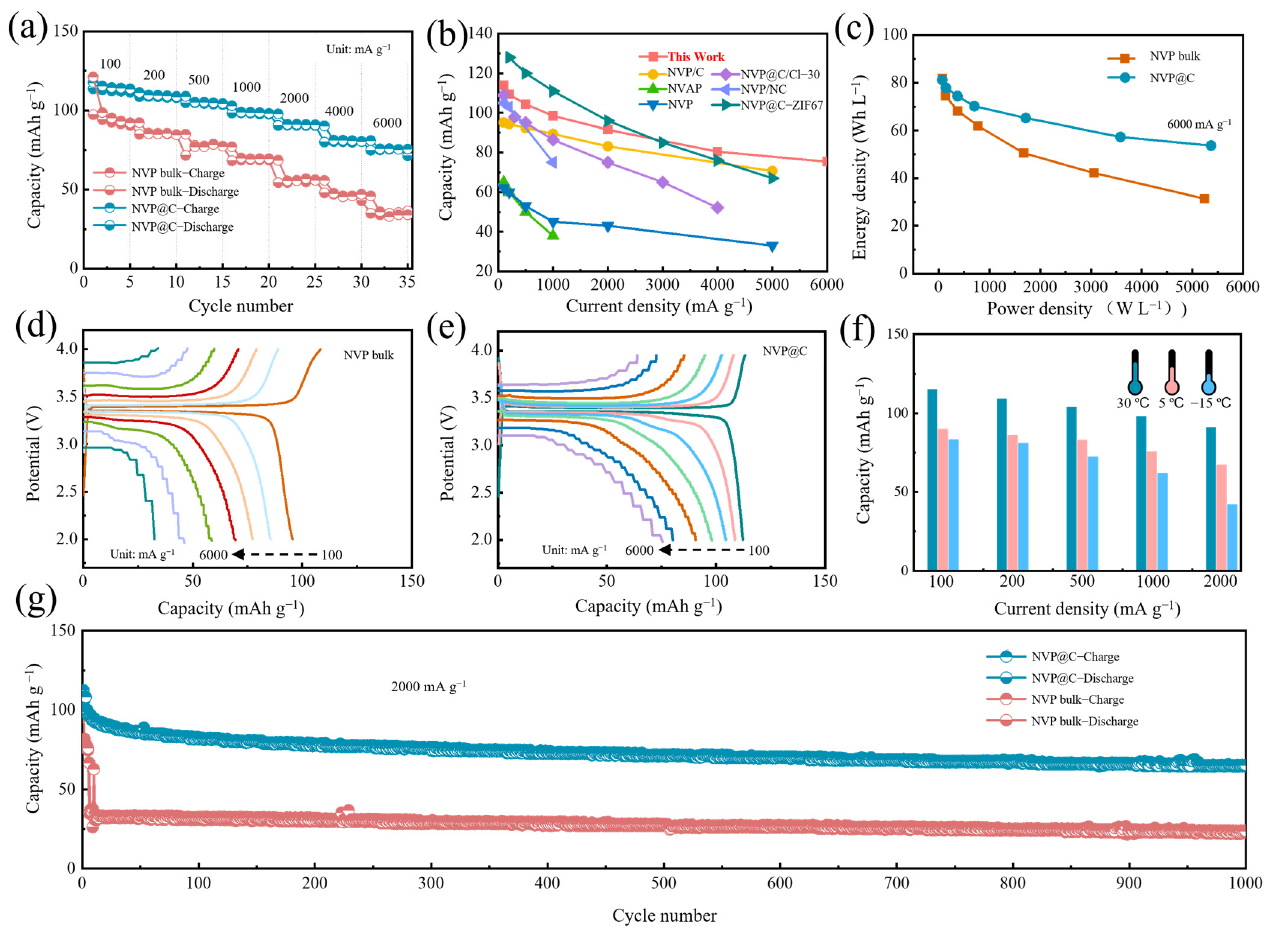
Figure 3. ( a ) Rate capability of NVP@C and NVP bulk; ( b ) comparison of the rate capability